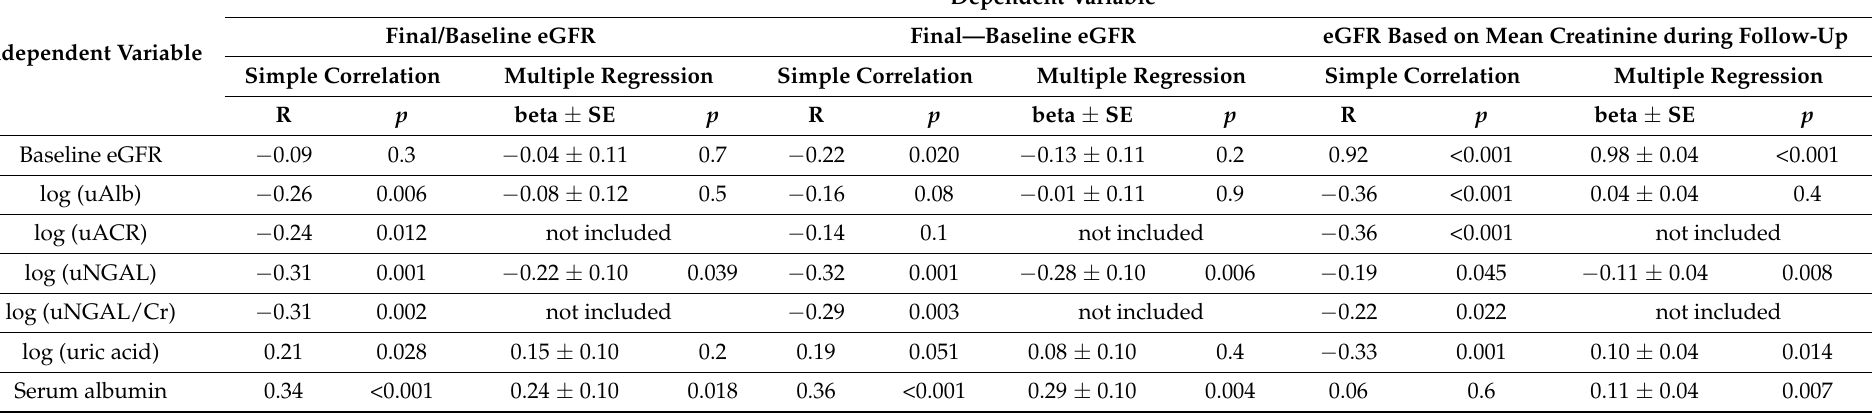
Table 3. Simple correlations and multiple models showing the associations between studied variables and the changes in eGFR values over the follow-up period (defined either as the follow-up to baseline eGFR ratio or as the difference between follow-up and baseline eGFR) and mean eGFR during the follow-up. The multiple models were adjusted for time from kidney